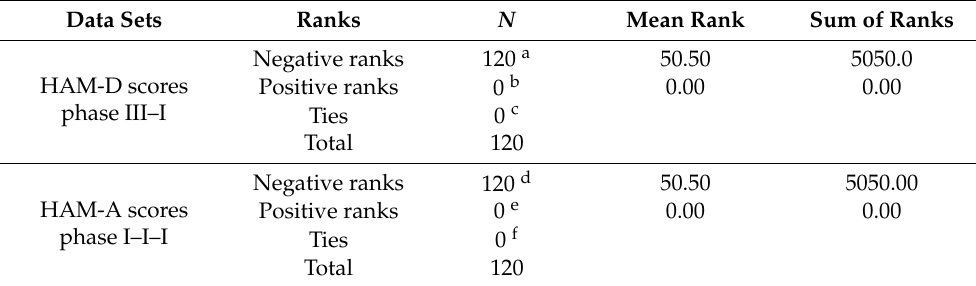
Table 5. Wilcoxon S-R test results–ranks table output.